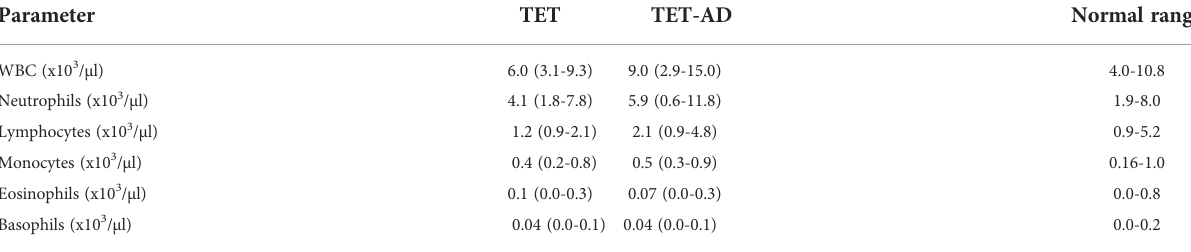
TABLE 1 Parameters of blood cell counts in TET and TET-AD patients vs. normal range